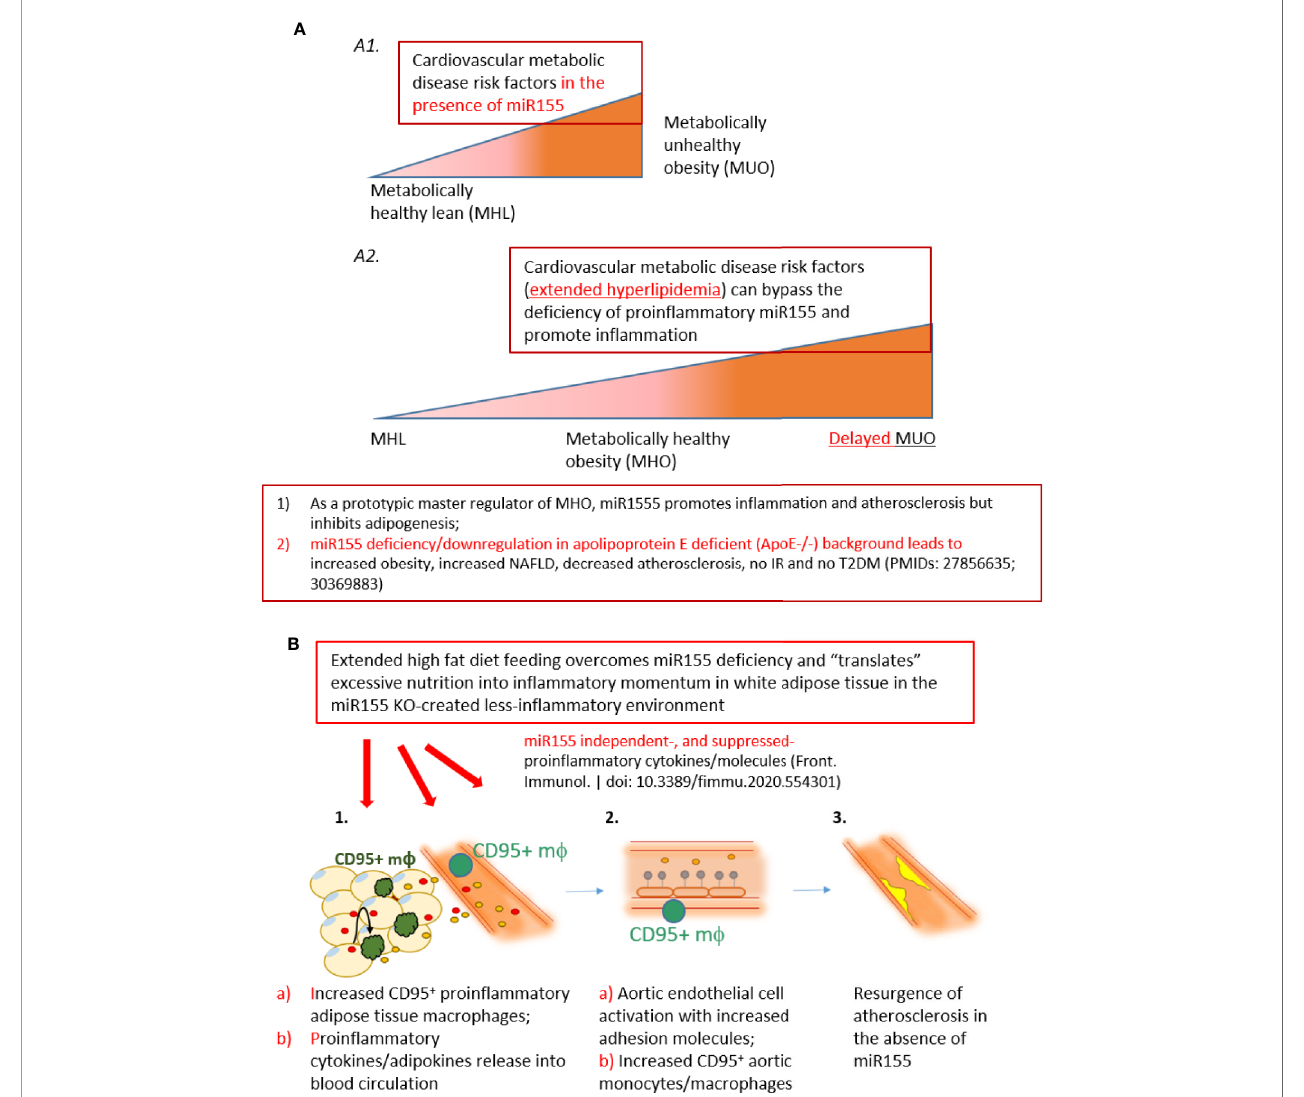
FIGURE 9 | A new working model: Extended high fat diet feeding overcomes the de fi ciency of proin fl ammatory miR155, generates CD95+ adipose tissue macrophages and secretes miR155 independent-, or miR155-suppressed proin fl ammatory cytokines/adipokines (second wave of in fl ammation), promotes aortic endothelial cell activation and increases atherosclerosis, which makes MHO transition to delayed MUO. (A) MHO is an intermediate stage in the development of delayed MUO. ( A1 ) in the presence of wild-type miR155, cardiovascular metabolic disease risk factors accelerate the progression of MHO from metabolically healthy lean; ( A2 ) In the absence of miR155, development of MUO need to go through an intermediate stage of MHO. (B) ( B1 ) Adipocyte (pale yellow with light blue nuclei)- secreted and macrophage-secreted TNF a (red dots) may promote CD95+CD86- macrophage phenotype (green). This macrophage subset together with peripheral blood CD95+ monocytes/macrophages may secrete pro-in fl ammatory cytokines and chemokines into the circulation (yellow dots), which in turn induce aortic EC activation, shown by ICAM1 upregulation ( B2 , gray dots). The CD95+ monocytes/macrophages in aortas may also secrete proin fl ammatory cytokines and contribute to EC activation ( B2b ) . (C) Over time, EC activation progresses towards atherosclerosis development ( B3 , bright yellow). Red dots: TNF a . Yellow dots: pro- in fl ammatory cytokines/chemokines/other